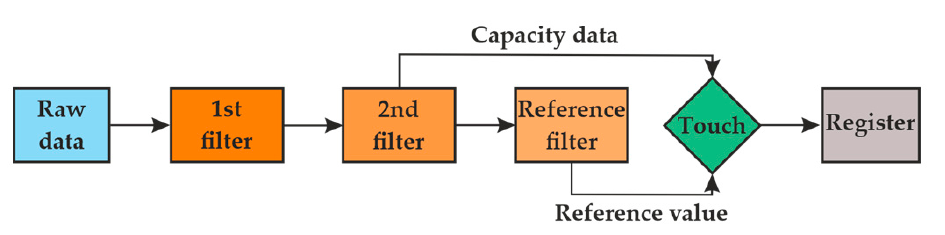
Figure 1. Data flow in the MPR121 capacitive sensor controller.